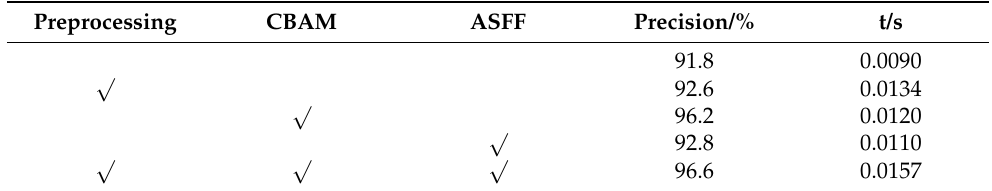
Table 5. Ablation experimental results.